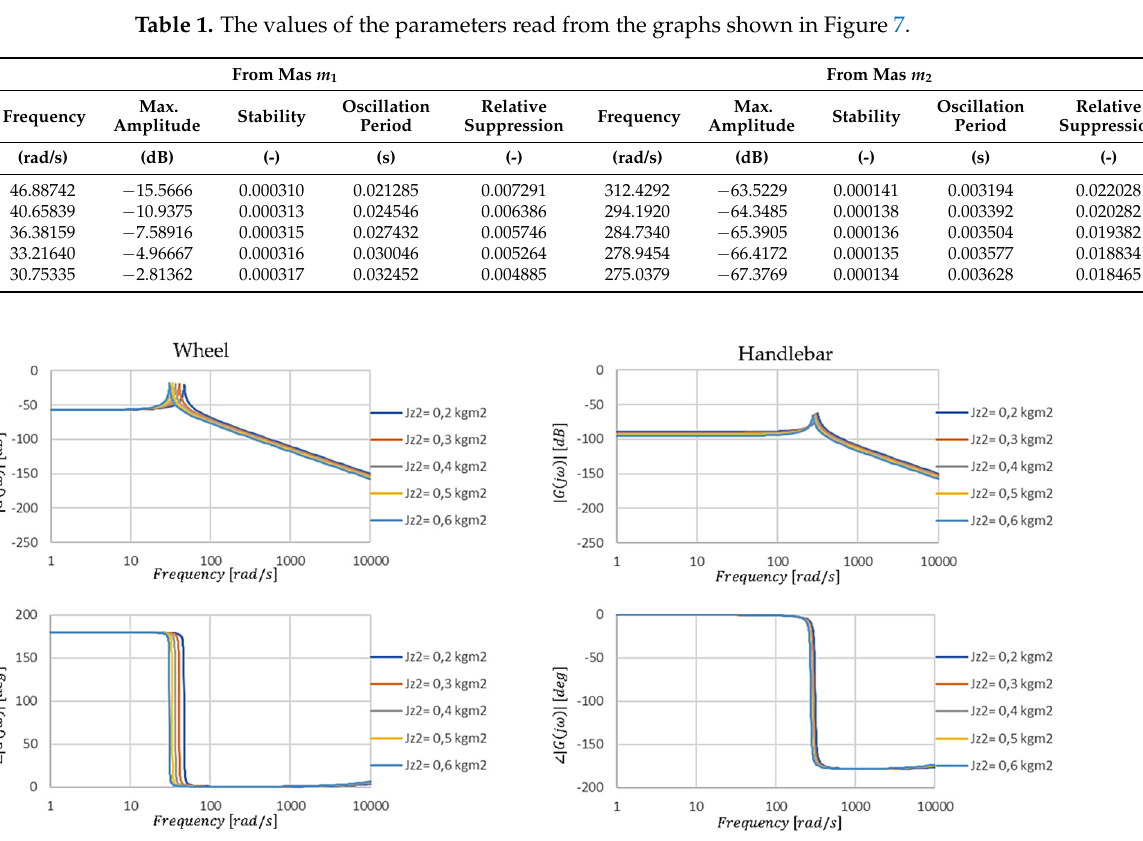
Figure 7. Amplitude and phase characteristics of the steering angle position transmittance when the parameter value is changed J z 2